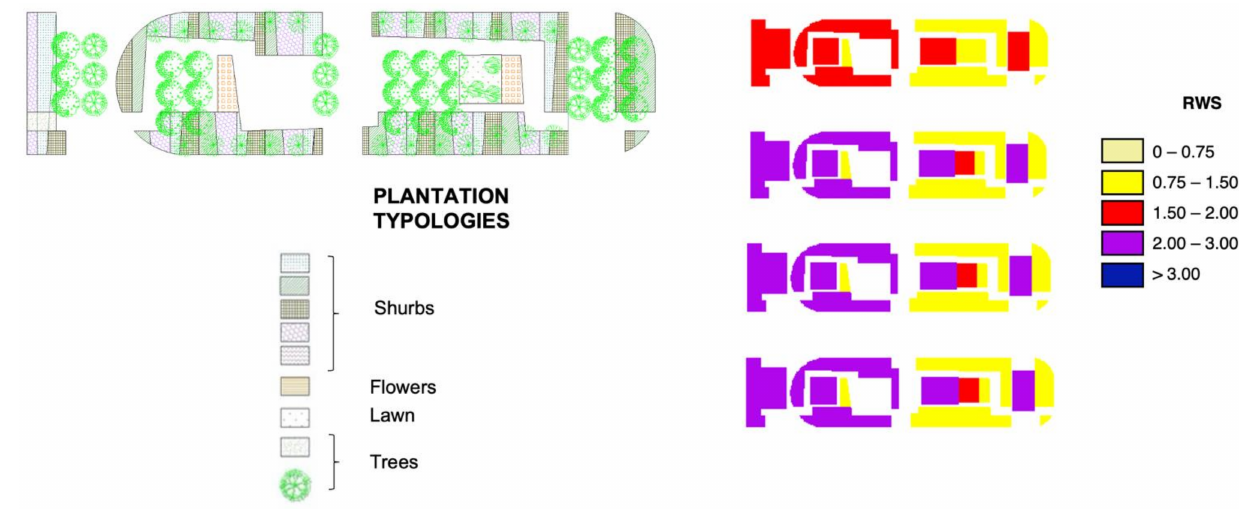
Figure 9. RWS map for park 302 considering the same weeks as those in Figure 8 for 2017 (0.75 < RWS < 1.5, optimal irrigation).